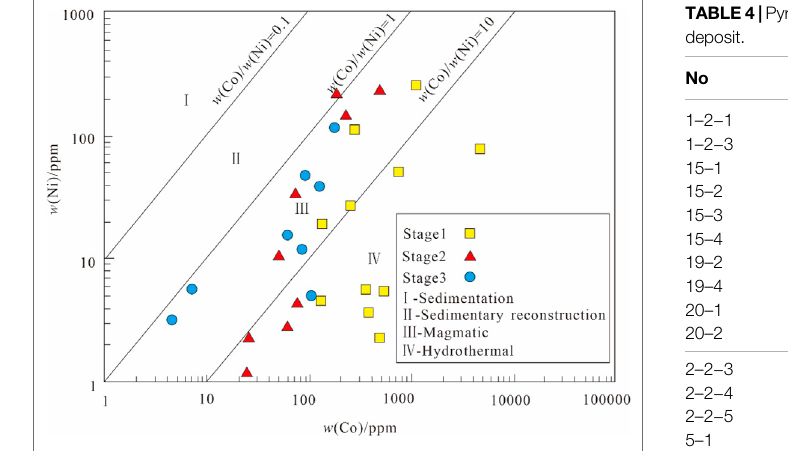
FIGURE 6 | Pyrite Ni-Co diagram for the Zhaoxian gold deposit (after Zhang C. et al., 2014).